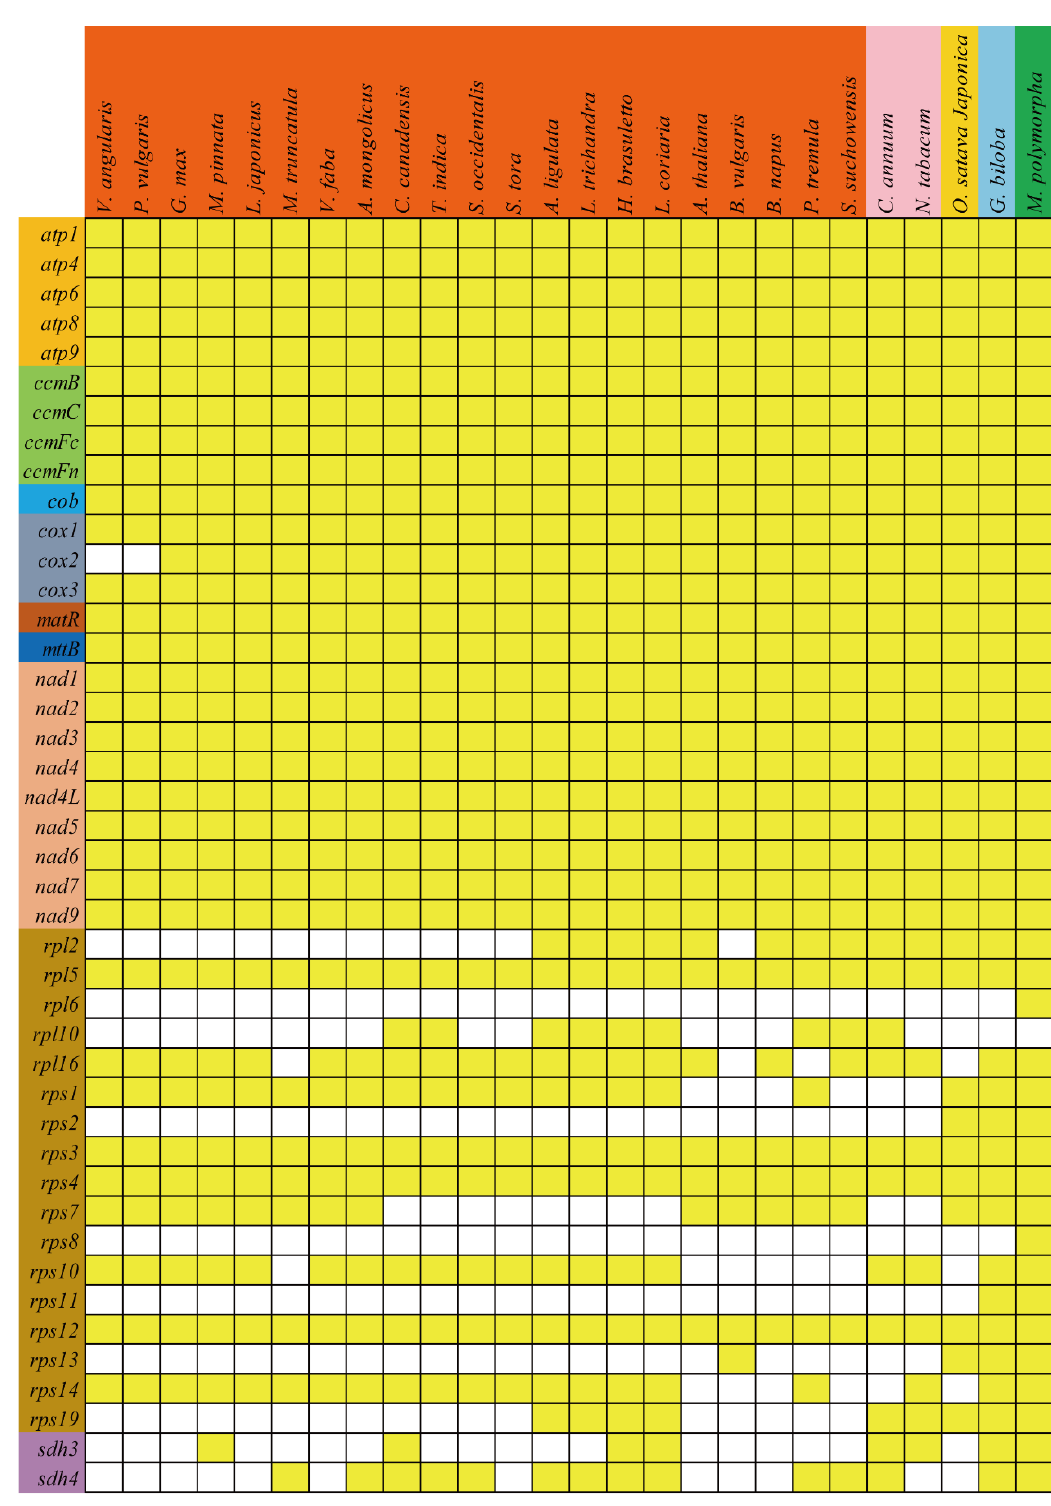
Figure 9. Distribution of PCGs in plant mitogenomes. White boxes indicate that the gene is not present in the mitogenome. The colors of genes indicate their corresponding categories. The colors of species represent the classes of rosids (orange), asterids (pink), monocotyledons (gold), gymnosperms (light blue), and liverworts (green).